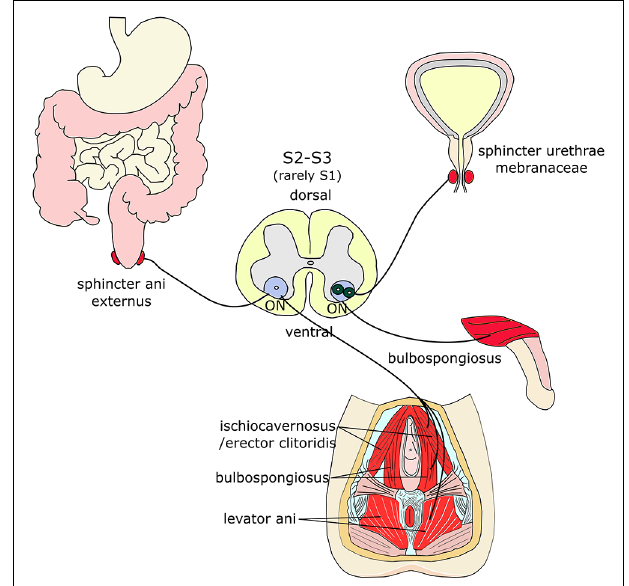
FIGURE 2 | Muscles innervated by Onuf’s MNs. Onuf’s (ON) MNs are located in the ventral horns of the upper sacral segment and innervate sphincters and muscles of the pelvic and perineal regions, such as the sphincter ani externus, the sphincter urethrae membranaceae, the bulbospongiosus, the ischiocavernosus (and its equivalent in females, erector clitoridis), and the levator ani muscles.